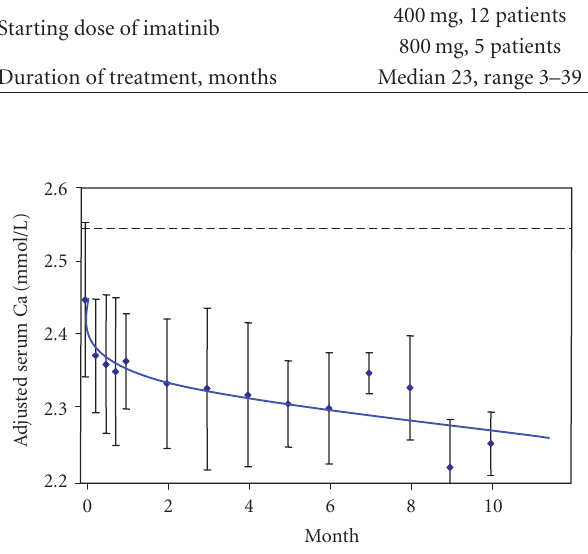
Figure 2: Changes in adjusted serum calcium in 17 patients receiv- ing imatinib for advanced GIST, shown as mean ± standard devia- tion. Reference range 2.2–2.55